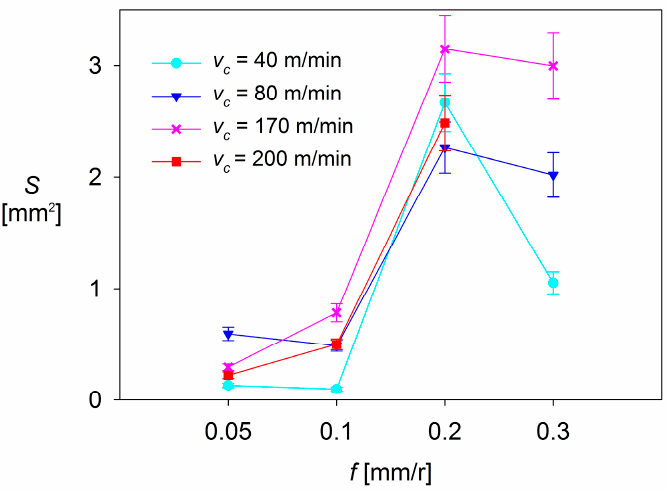
Figure 14. S = f( v c , f ), for a p = 2 mm.